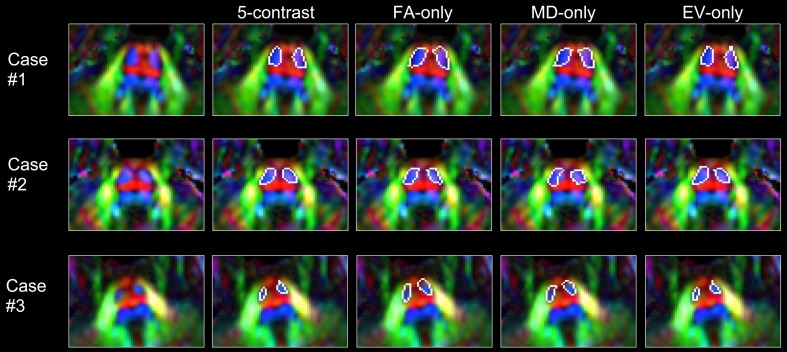
Examples of CST parcellations from single- and multi-contrast approaches.Demonstration of the parcellation accuracy of the CST in three representative cases with different degrees of anatomical abnormalities. Results from five different approaches are compared.